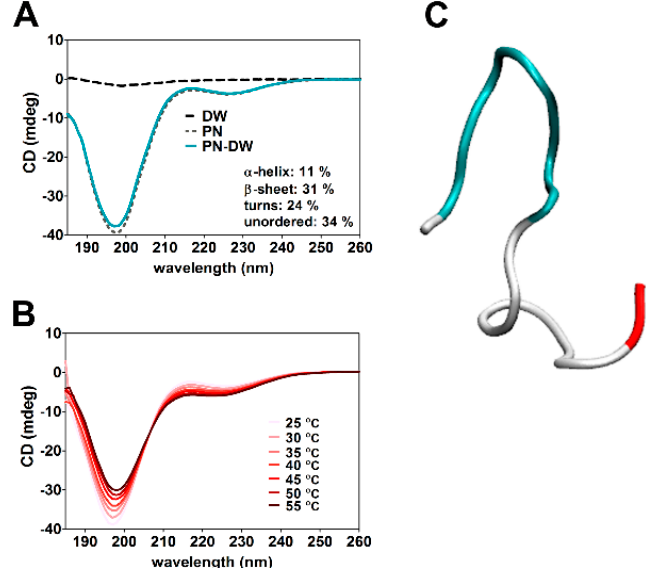
Figure 5. ( A ) Circular dichroism (CD) spectroscopy of PN159 peptide at 25 °C. ( B ) Thermostability measurement of the peptide structure. ( C ) Structure of PN159 by molecular modeling. Blue color: turn motifs; White color: coil-coil motifs; Red color: C-terminal region.